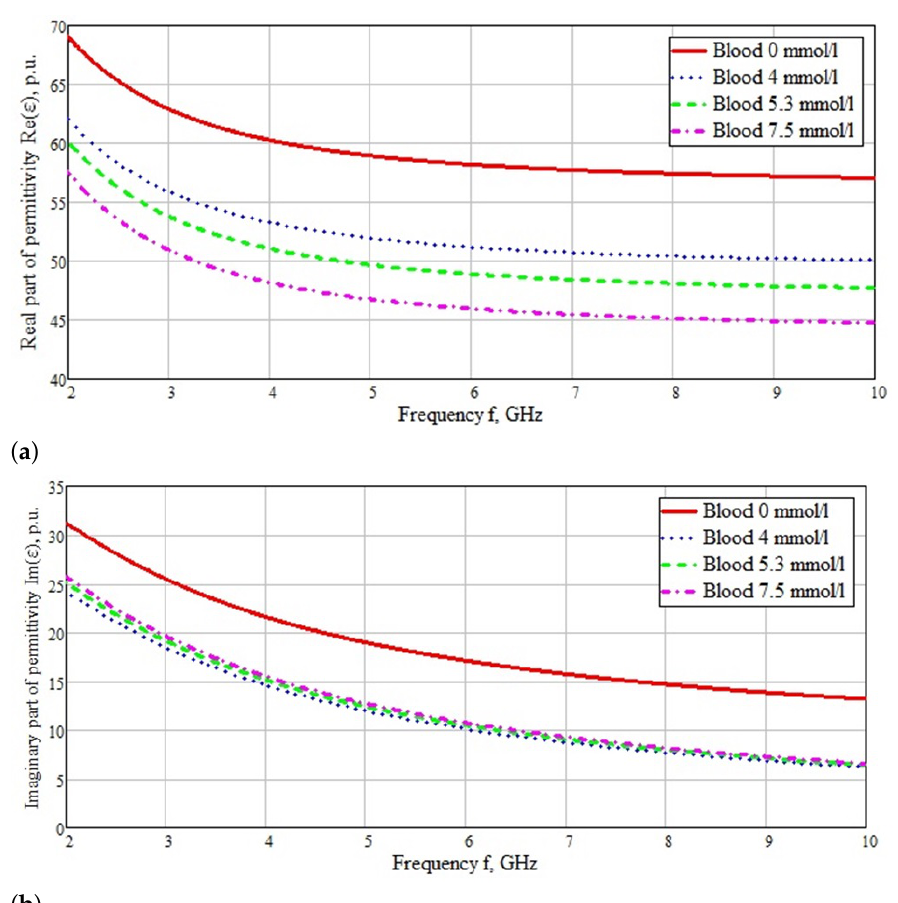
Figure 4. Frequency dependence of the real ( a ) and imaginary ( b ) parts of the relative permittivity on the frequency for blood with different glucose